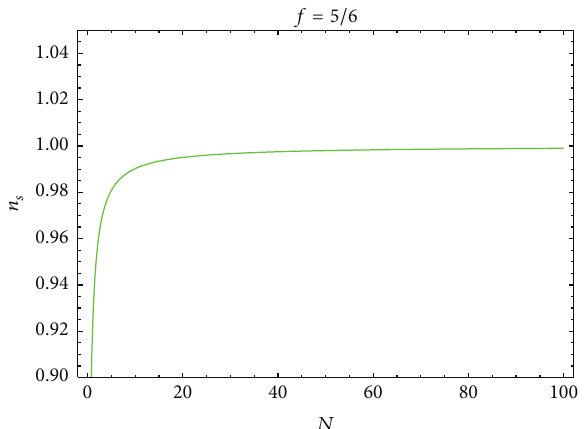
Figure 5: In this graph we plot the spectral index 𝑛 𝑠 in terms of the number of e-folds 𝑁 . We can find best range of spectral index ratio, where 𝑁 > 60 .